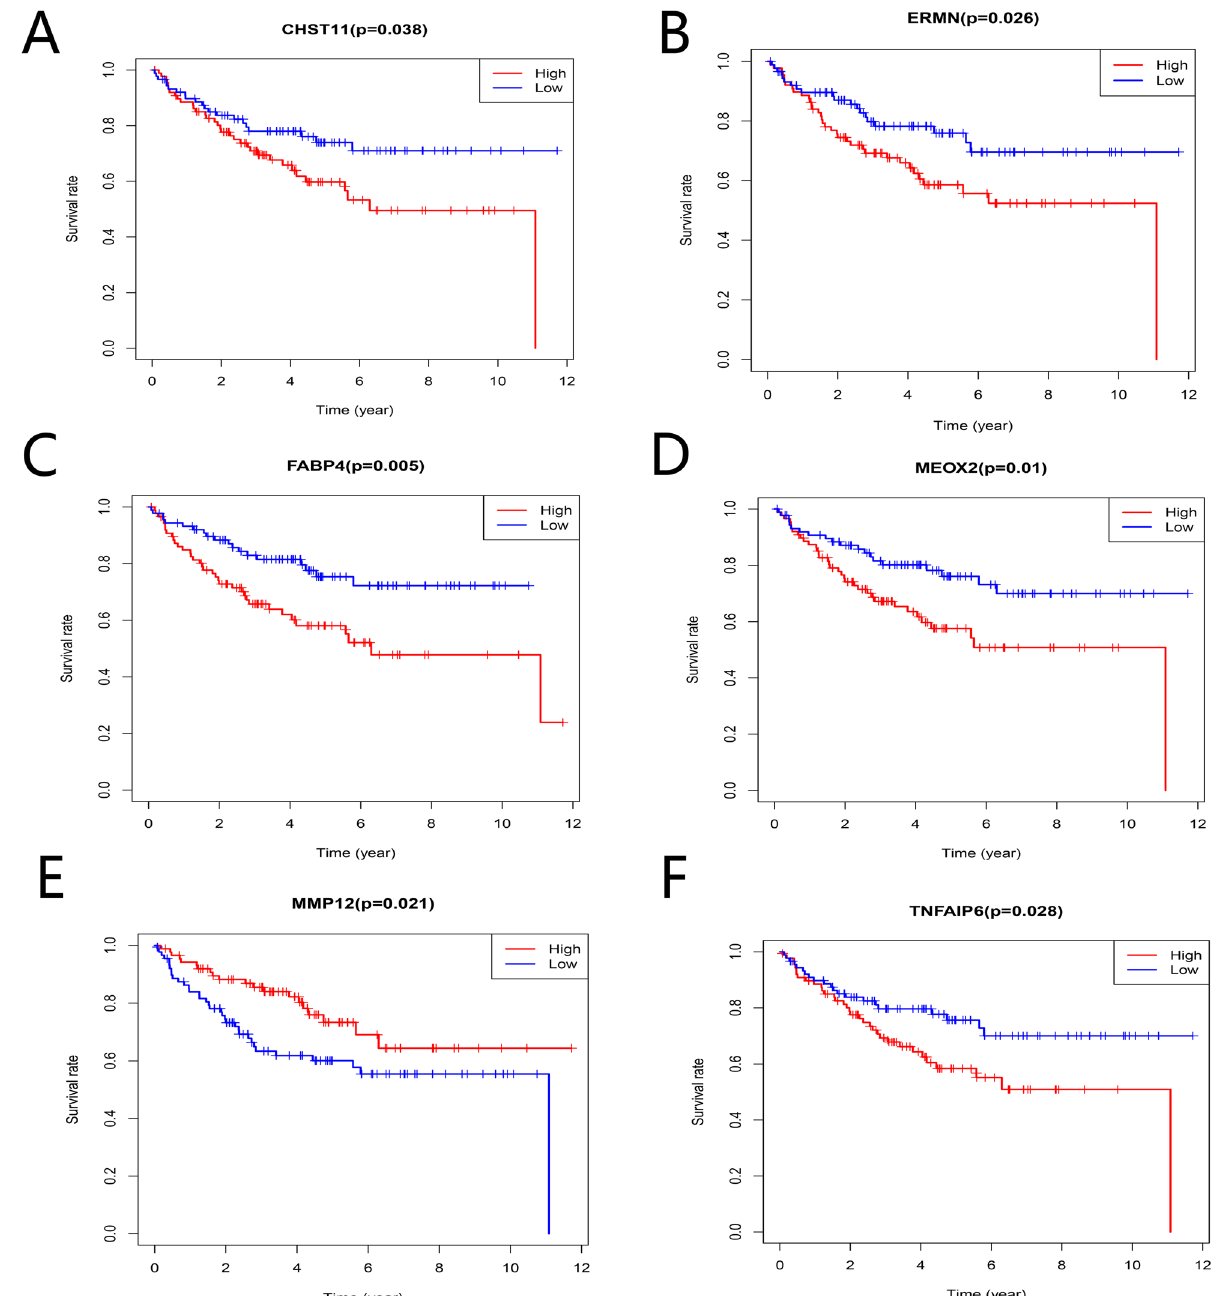
Figure 6. Validation of correlation of DEGs associated with prognosis extracted from TCGA database with overall survival in GSE17538 of GEO database. Six genes (MMP12, CHST11, ERMN, FABP4, MEOX2, and TNFAIP6) were verified to be related to prognosis. p <